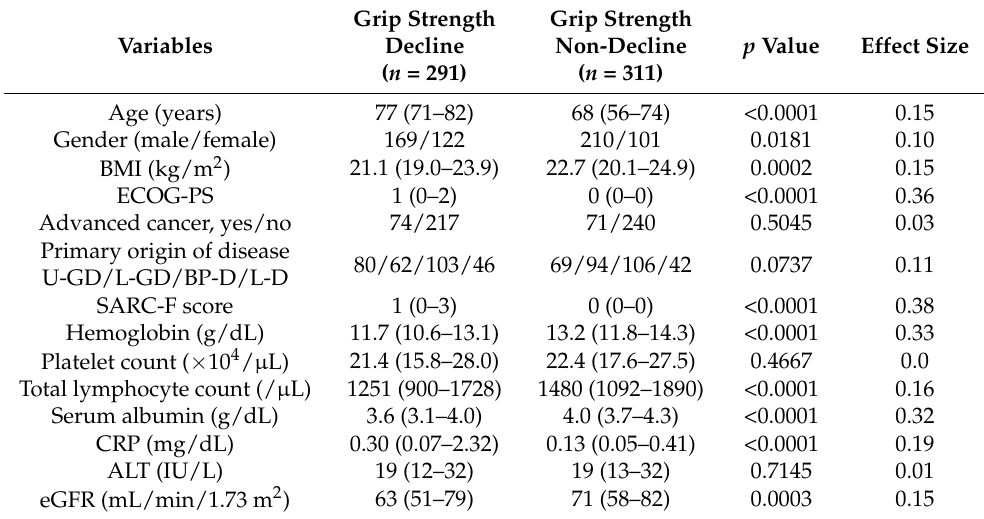
(Table 3). Table 3 involves hazard ratio and 95% confidence interval in each factor. Table 2. Univariate analysis of factors associated with the grip strength decline.